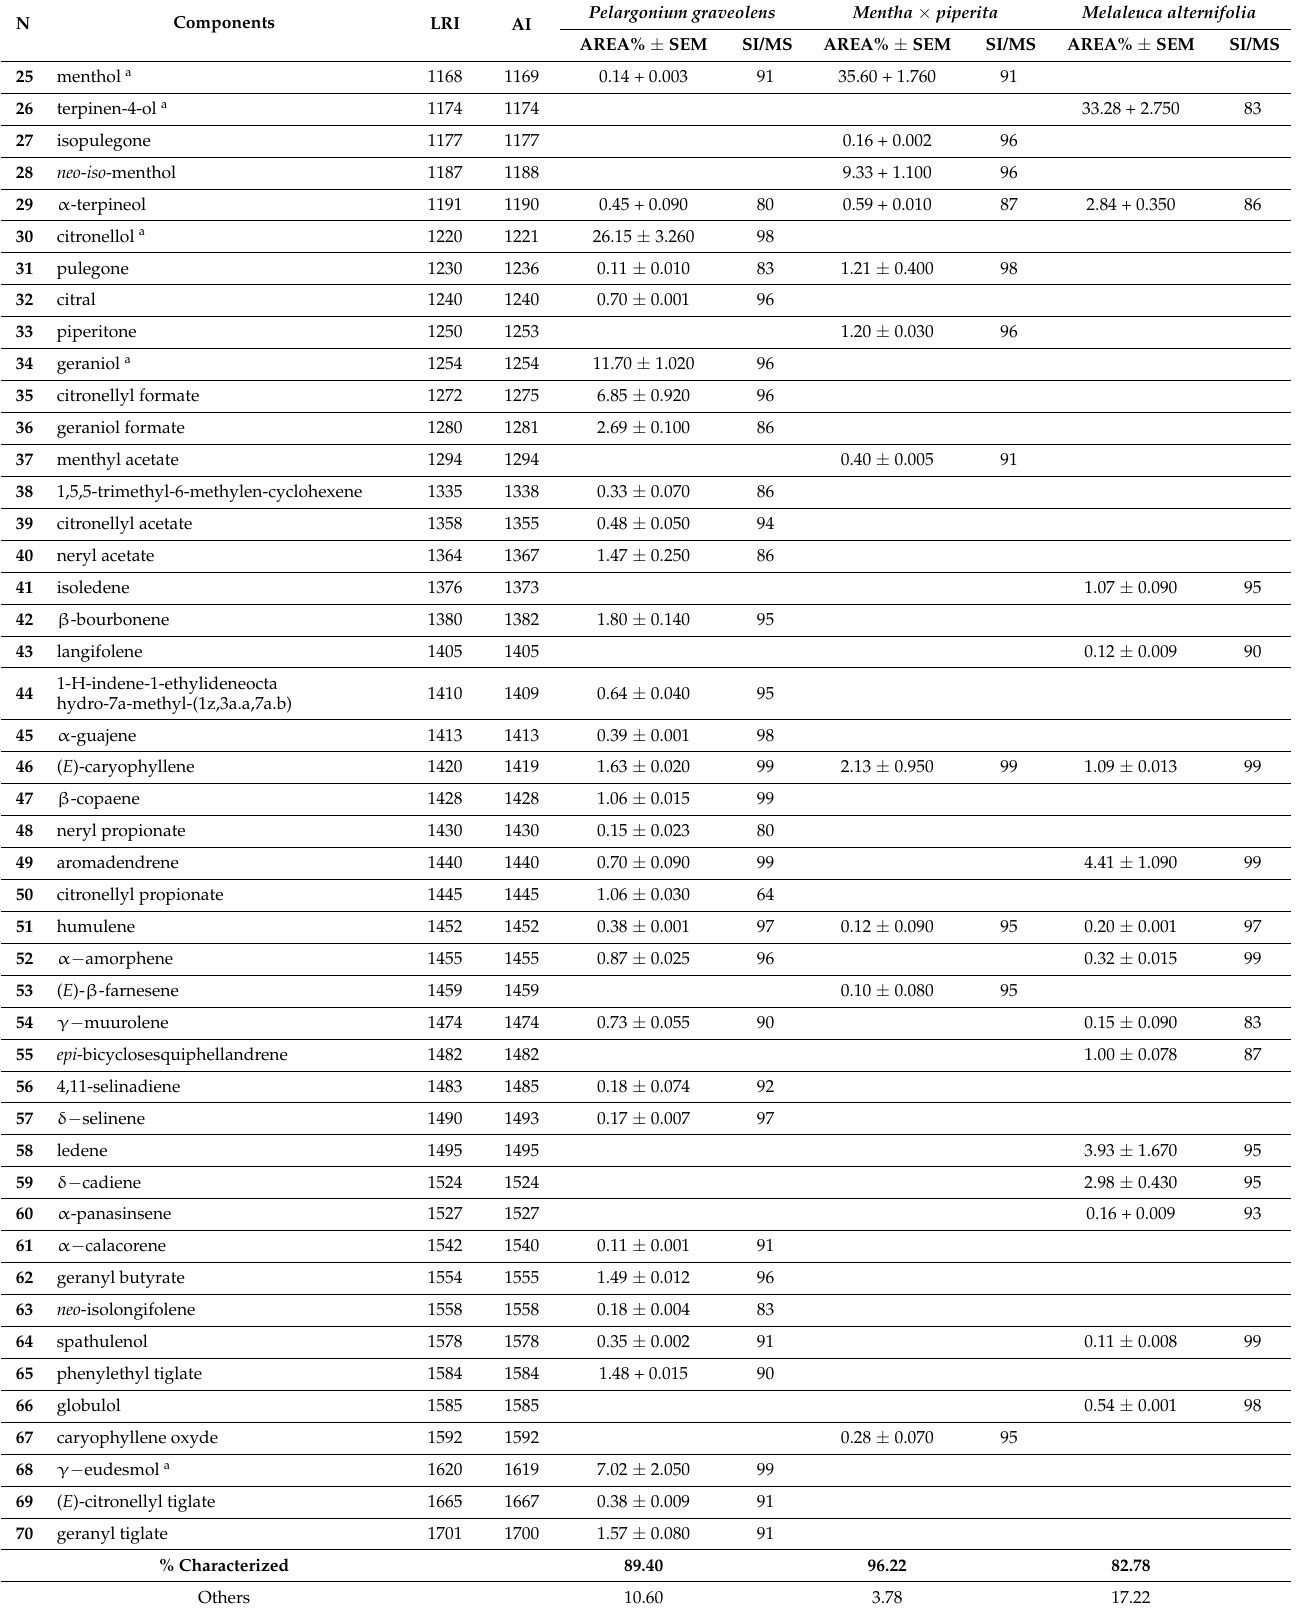
Table 1. Chemical composition of tested Essential Oils